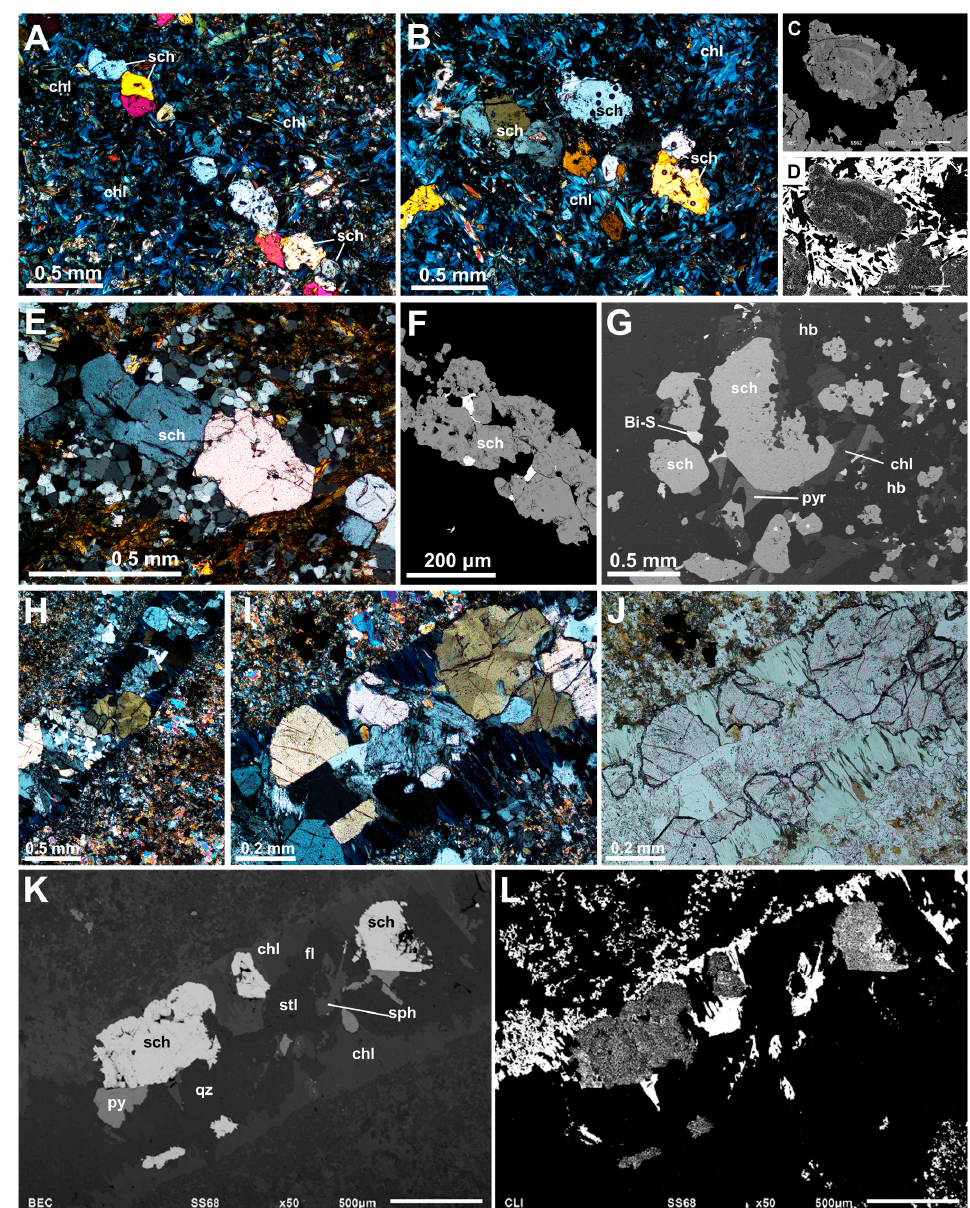
Figure 4. Optic and SEM images of stage II, III, and IV scheelites. ( A – D ) Stage II scheelite shows scheelite-dominated vein structure. Secondary chlorite alteration is well observed throughout overall section. Oscillatory zoning with dented zones is commonly observed. Scheelite grains are mid-sized subhedral to anhedral grains; rim parts have overgrowth of pure scheelite with brighter CL. ( E – G ) Stage III scheelite shows scheelite-dominated vein structure but quartz is more abundant than stage II scheelite. Scheelite grains are relatively smaller than stage II scheelite, with anhedral to subhedral shape and elongation along the vein. No specific internal structures are shown in CL or BSE images. Native bismuth commonly exists as inclusions; bismuthinite and pyrrhotite appear as dominant sulfide phase. ( H – L ) Stage IV scheelite shows quartz-dominated vein structure, showing later stilbite alteration. Scheelites have smallest size and are disseminated along the veins. Grain boundaries are commonly dissolved and secondary chlorites grow with saw-blade shape along the vein margins. No specific internal structures are visible in the scheelite grains. Pyrite appears as dominant sulfide phase